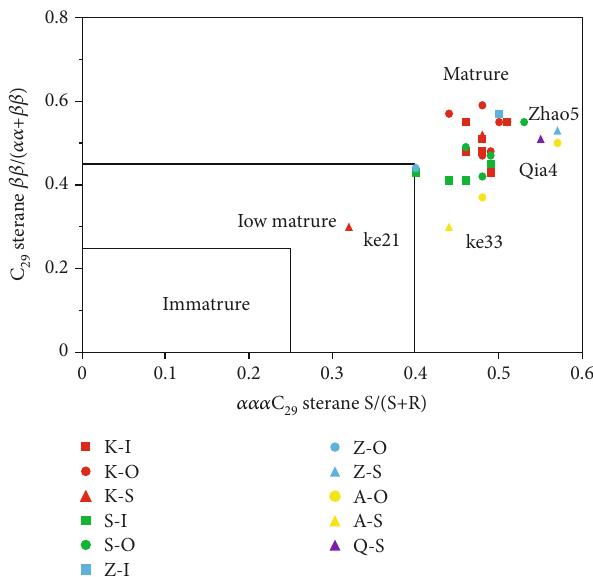
Figure 11: Cross-plot of ααα C sterane S/(S+R) and C sterane 29 29 ββ /( αα + ββ ) in the inclusions, oil, and sandstones of the northern piedmont belt of the Turpan-Hami Basin. Note: K-I: Kekeya- inclusion; K-S: Kekeya-sandstone; K-O: Kekeya-crude oil; S-I: Shanle-inclusions; S-O: Shanle-crude oil; Z-I; Zhaobishan- inclusions; Z-O: Zhaobishan-crude oil; Z-S: Zhaobishan- sandstone; A-O: Aketashi-crude oil; A-S: Aketashi-sandstone; Q- S: